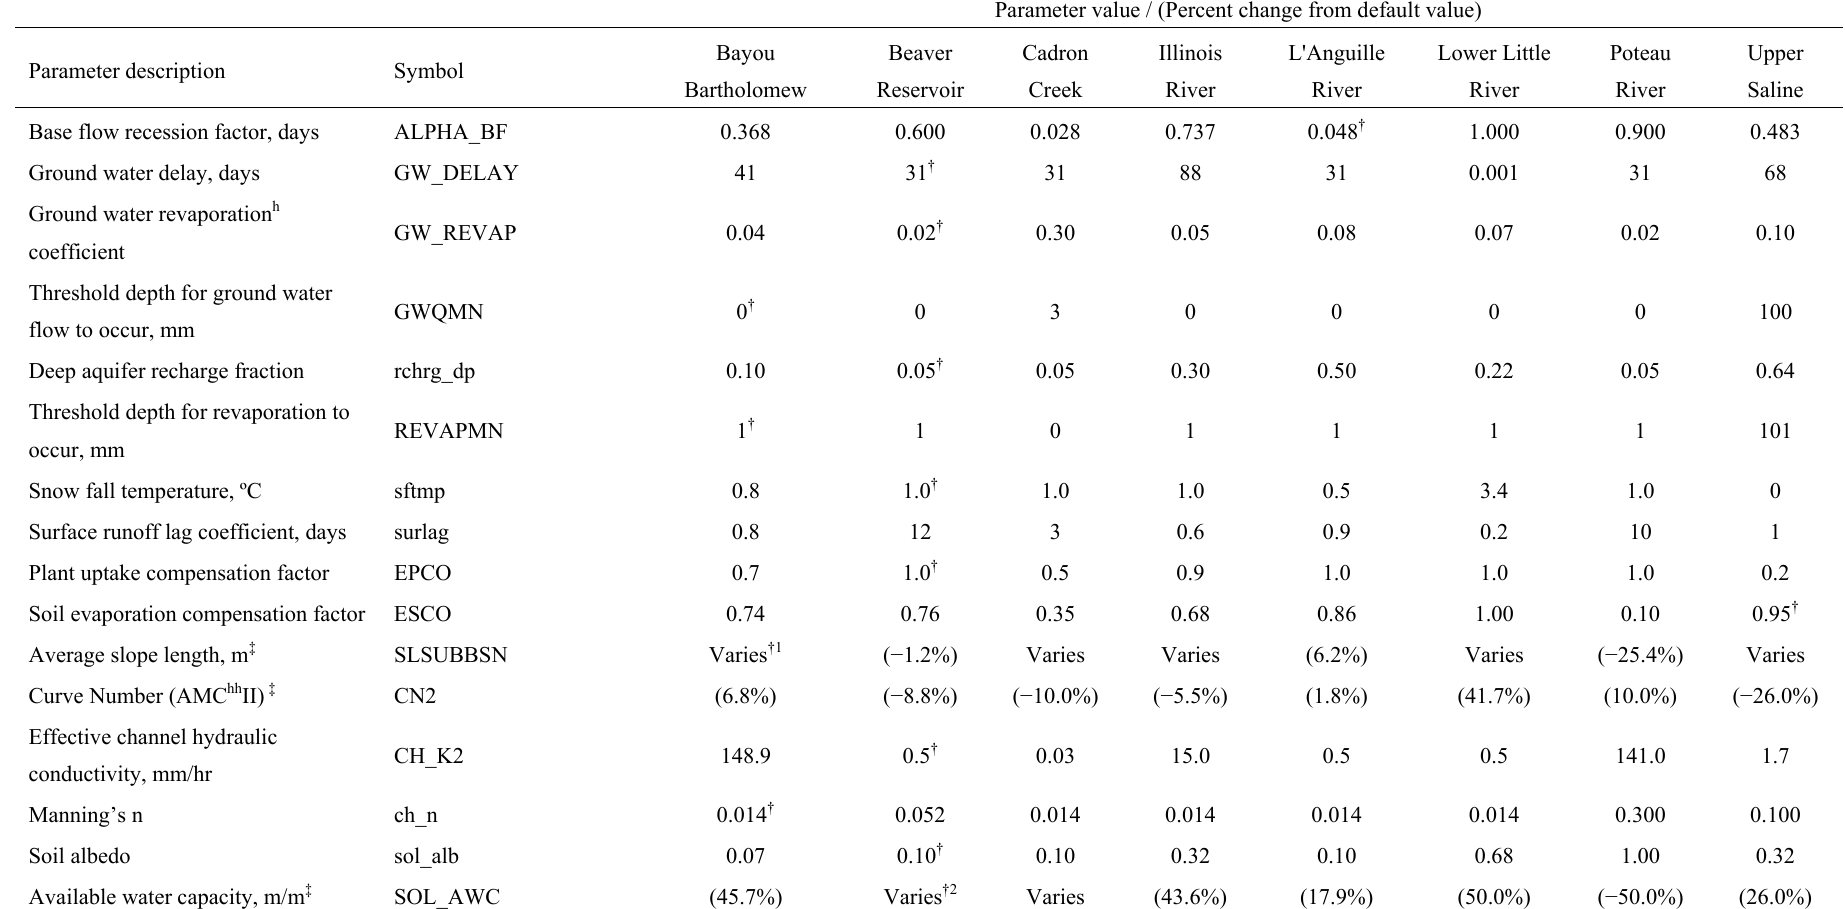
Table 1. SWAT model parameters used in